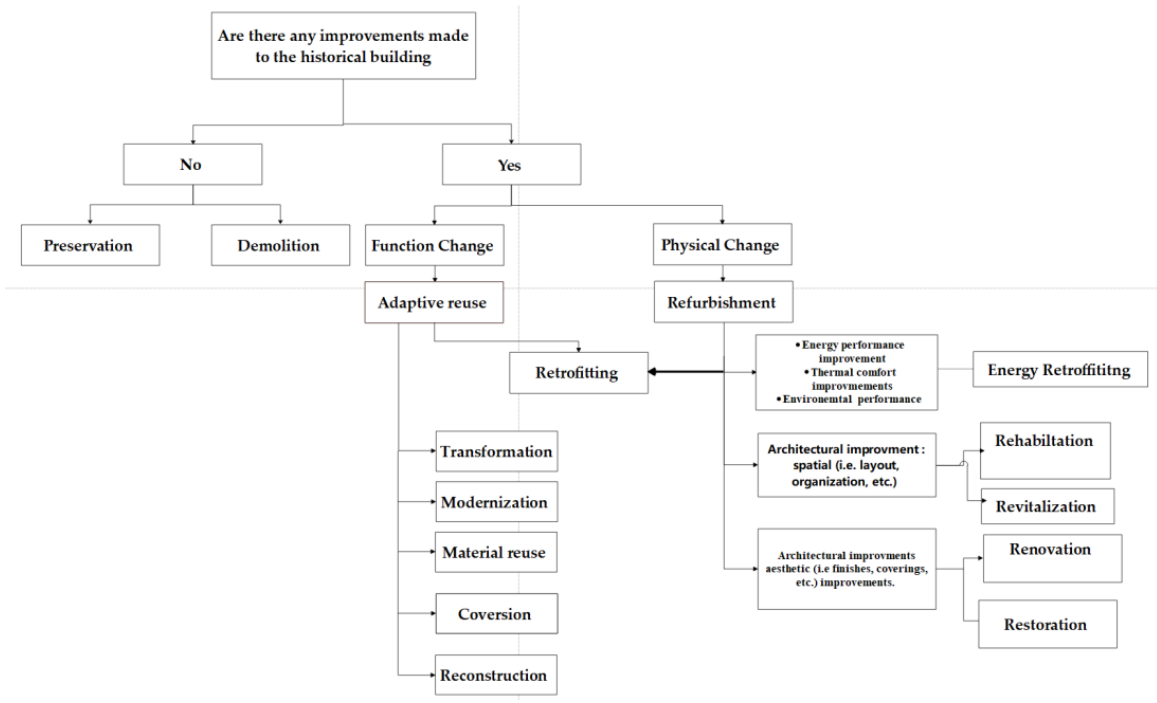
Figure 5. Theoretical model based on heritage building adaptation.